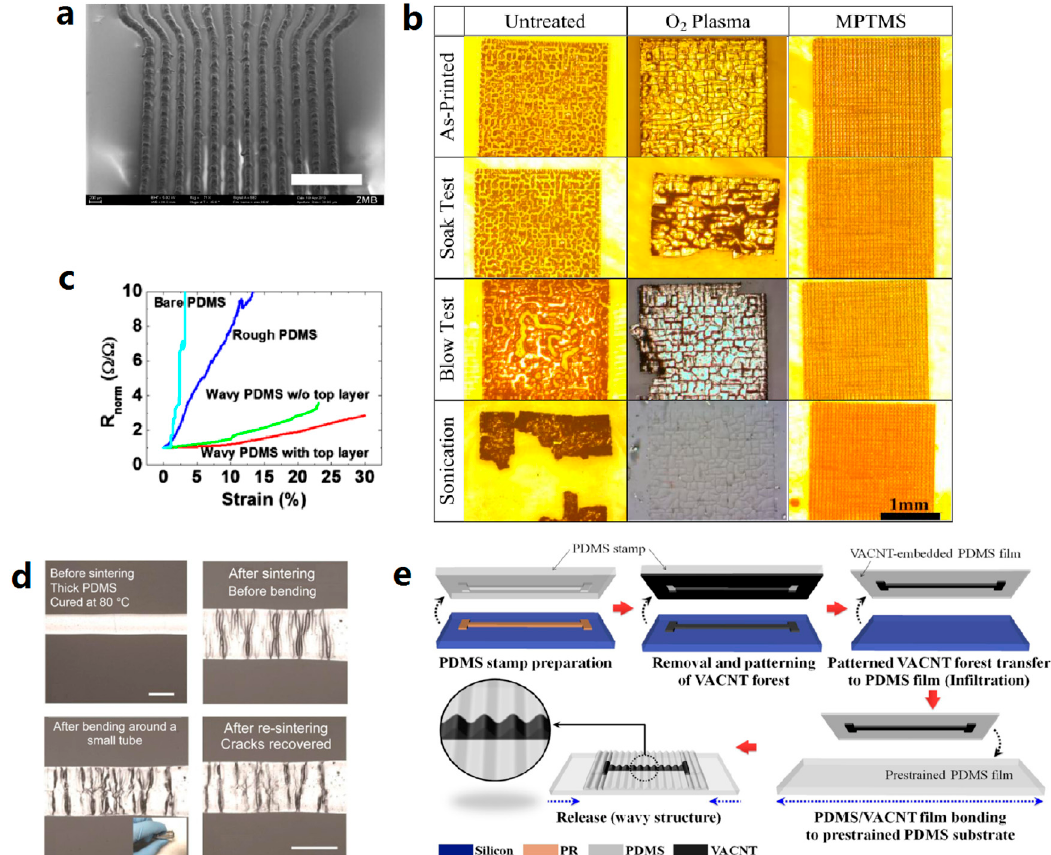
Figure 6. ( a ) SEM image of stencil printed Ag/PDMS tracks with the highest resolution achieved